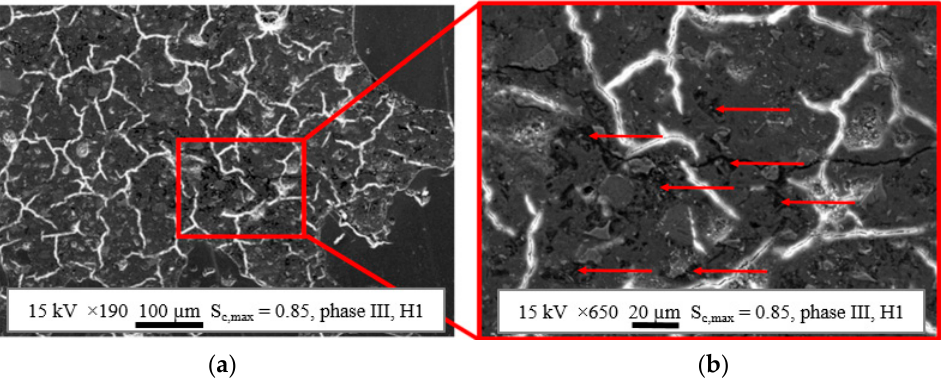
Figure 10. Examples of secondary electron images of concrete microstructure of the bluish impreg- nated area near to the aggregates at a magnification of 190× ( a ) and microstructural details at a mag- nification of 650× ( b ).